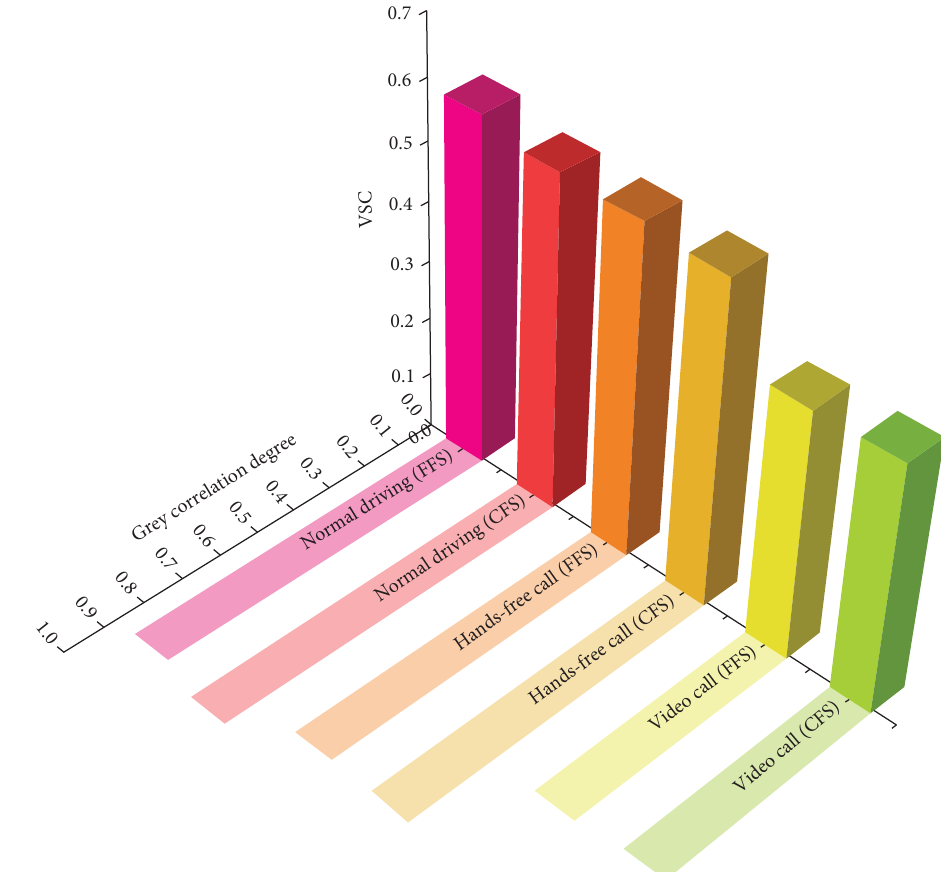
Figure 13: Change of VSC and grey correlation degree in diferent trafc conditions and driving